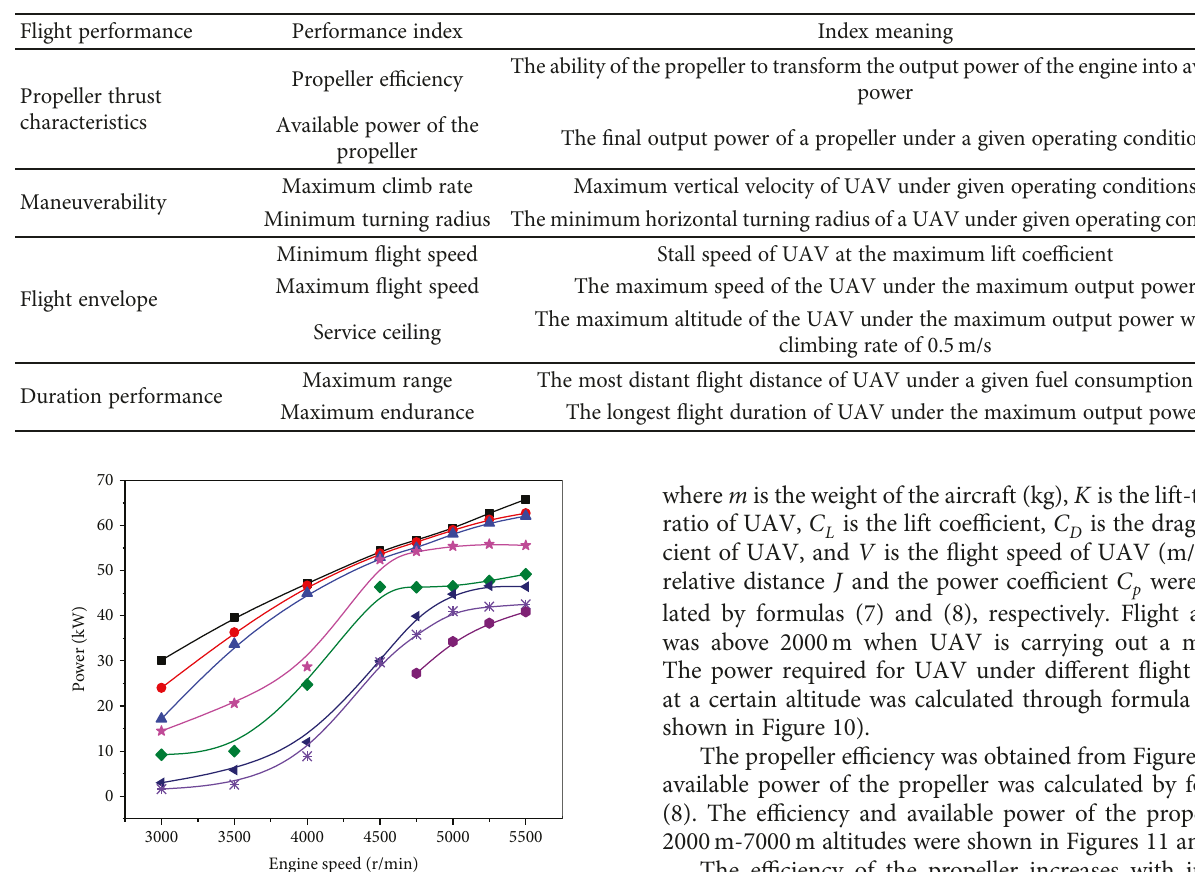
Table 2: Flight performance parameters of UAV.